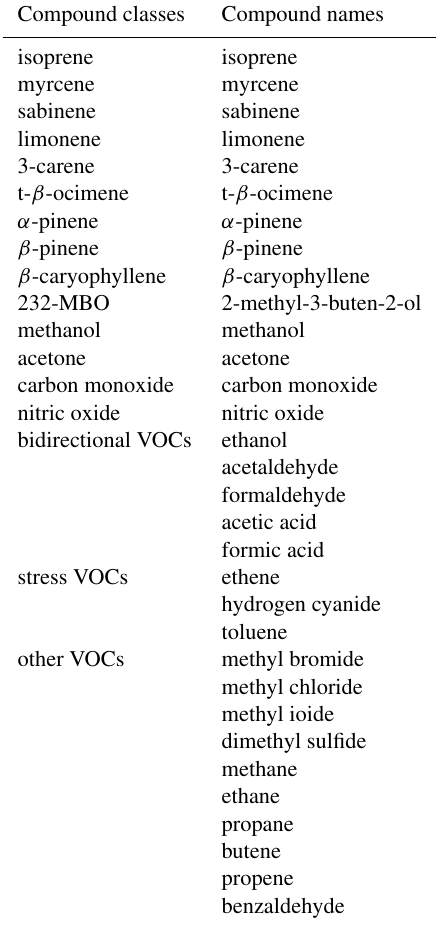
Table 1. Biogenic compound classes and individual compounds in- cluded in the biogenic emission